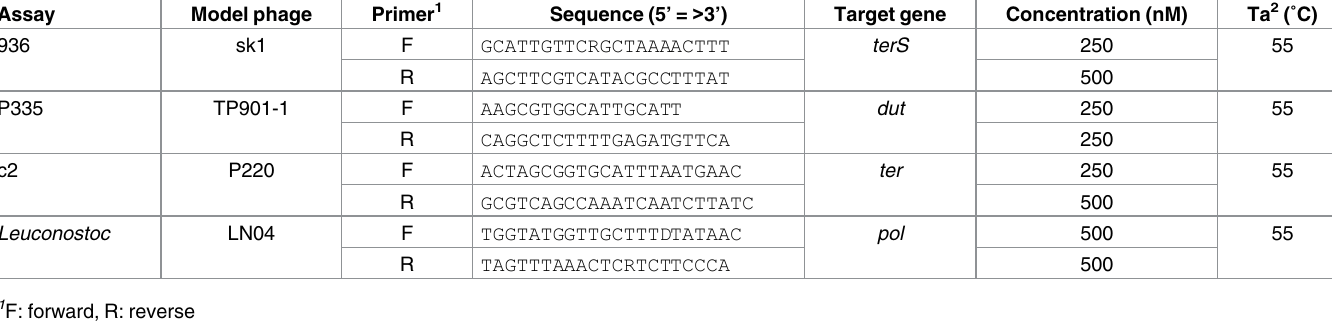
Table 1. Species-specific primers designed for phages attacking L . lactis and Leuconostoc